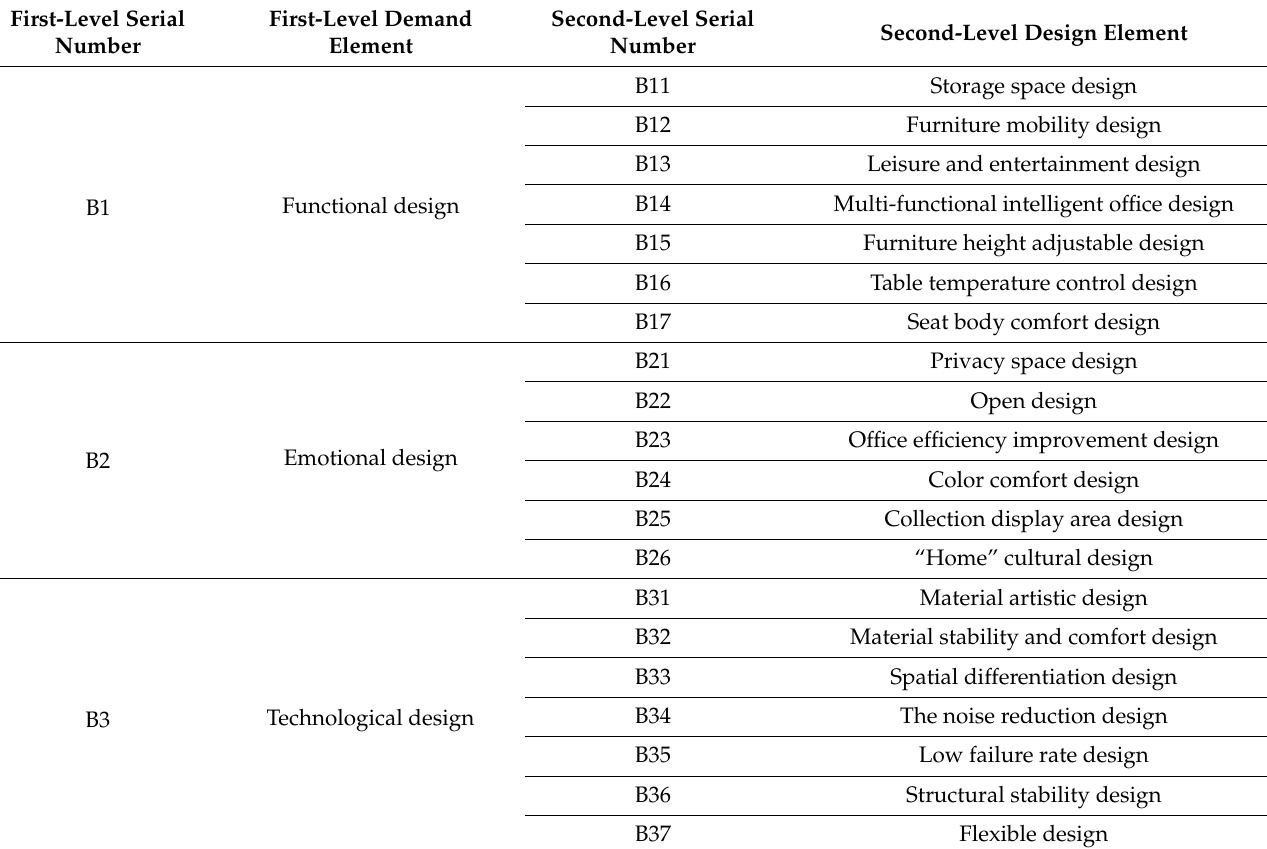
Figure 6. Demand degree comprehensive evaluation results. Table 6. Hierarchy of design requirements.